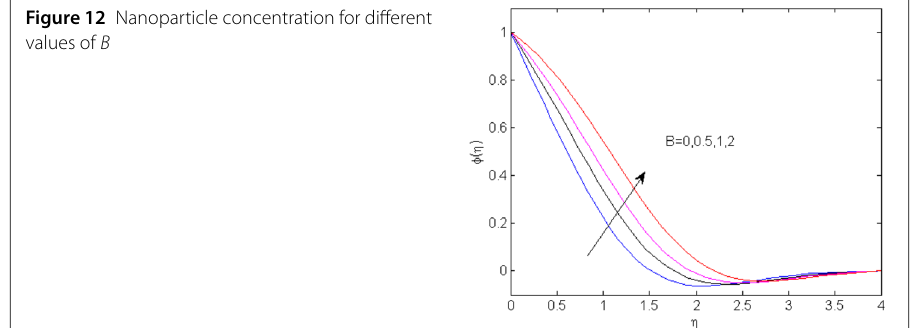
Figure 12 Nanoparticle concentration for different values of B